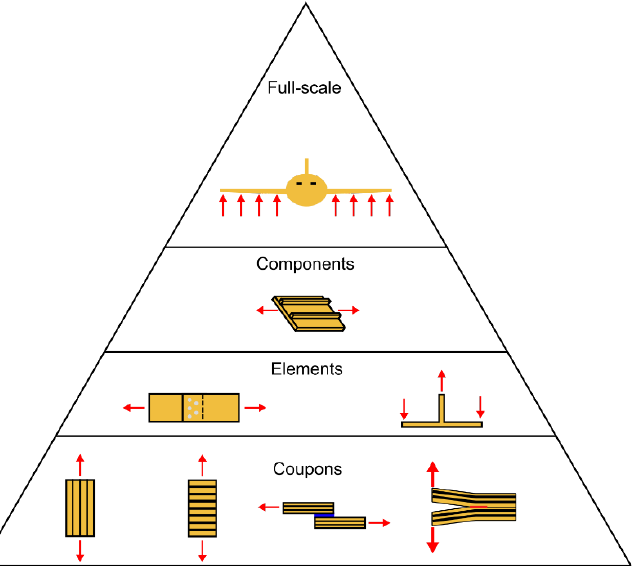
Figure 1 . Schematic example of a test pyramid for a composite aircraft. In practice, additional interme-diate levels may be defined (see, for example, [22]); the red arrows schematically indicate the direction of the applied loads for the different test cases (the magnitude of the arrows does not necessarily correlate with the applied loads).